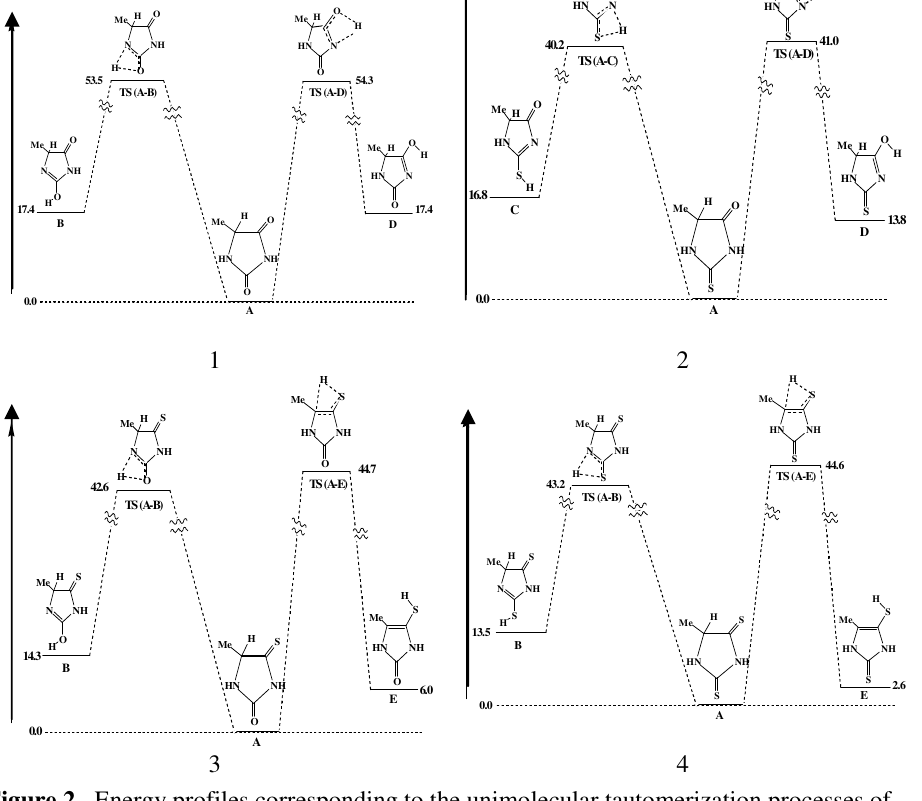
Figure 2. Energy profiles corresponding to the unimolecular tautomerization processes